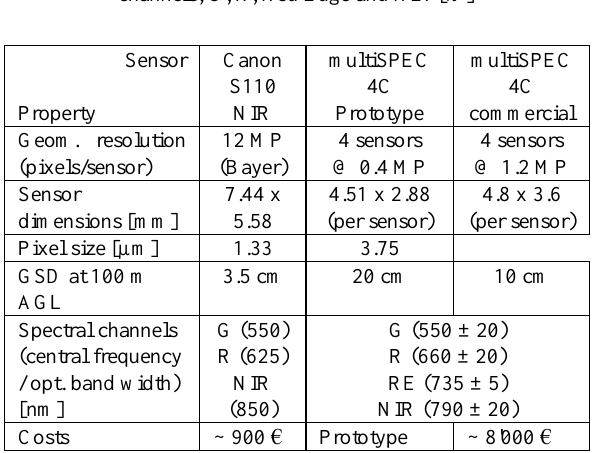
Figure 3. multiSPEC 4C with normalised sensitivity of channels, G, R, Red Edge and NIR [%]